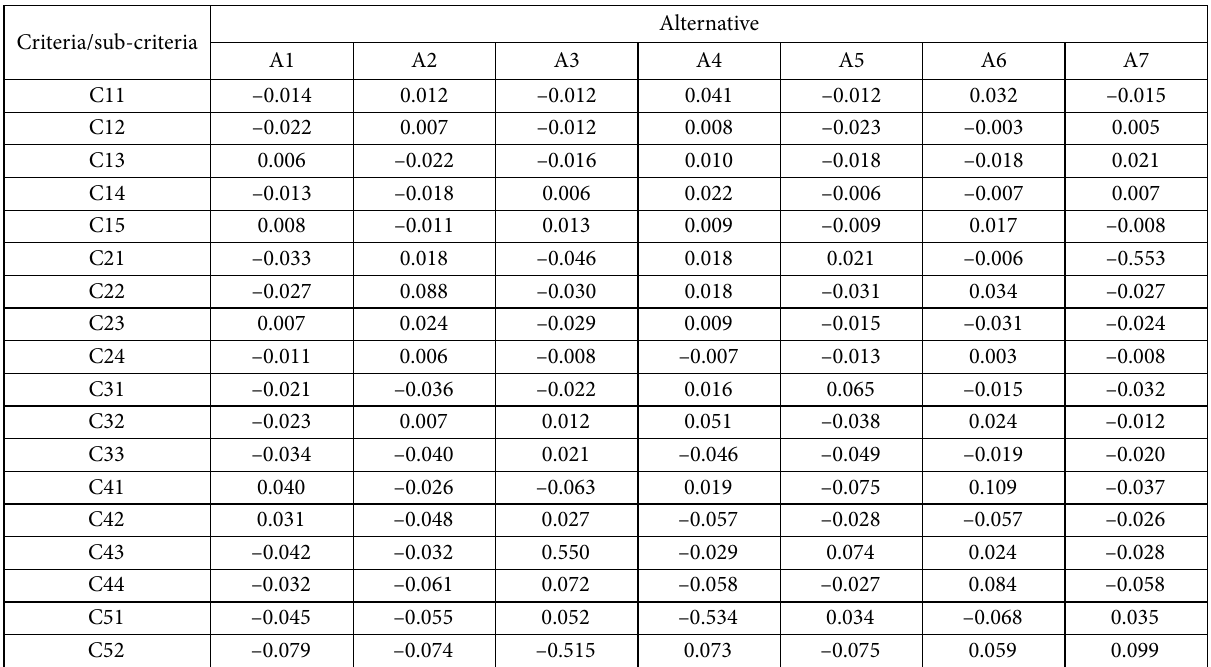
Table 9. Distance of the alternatives from the BAA